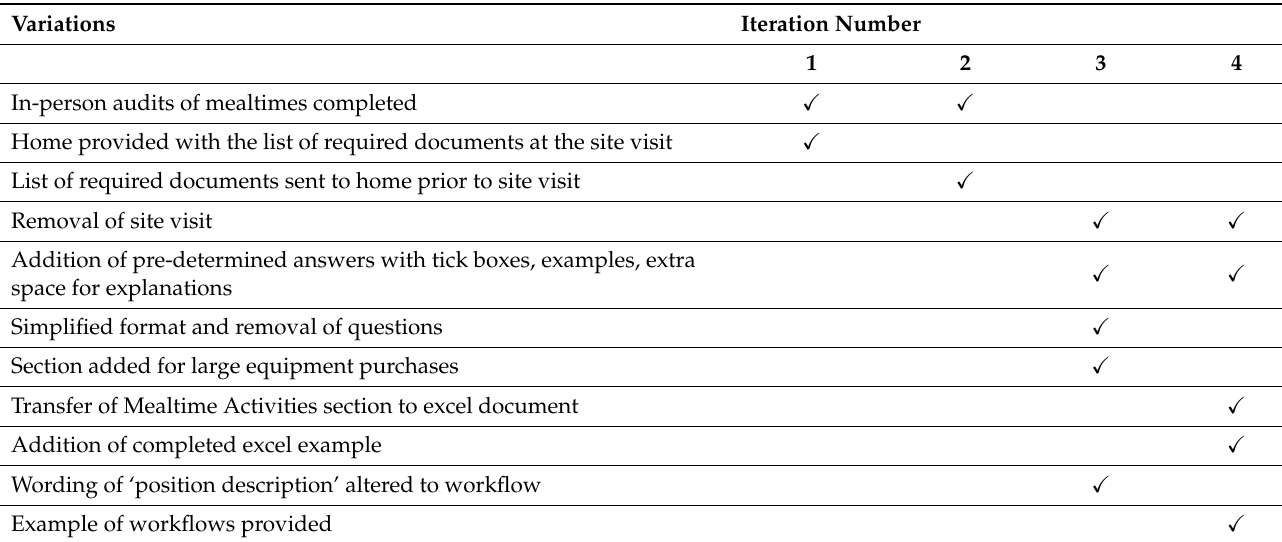
Table 3. Variations made over each